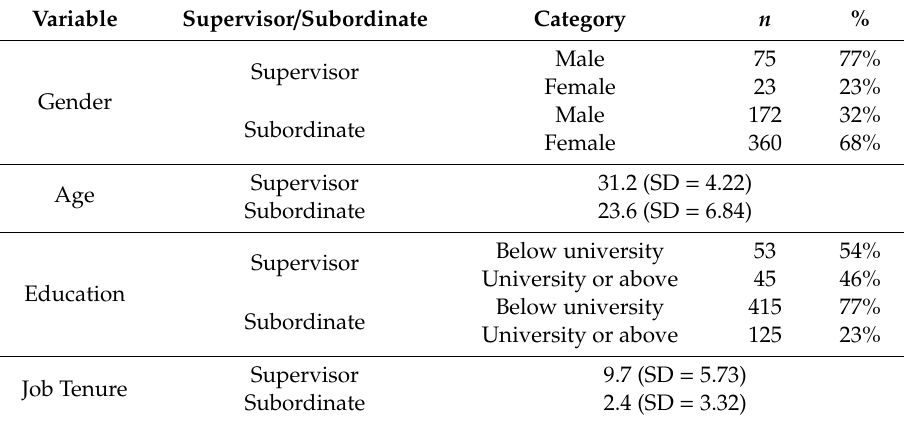
Table 1. Participant